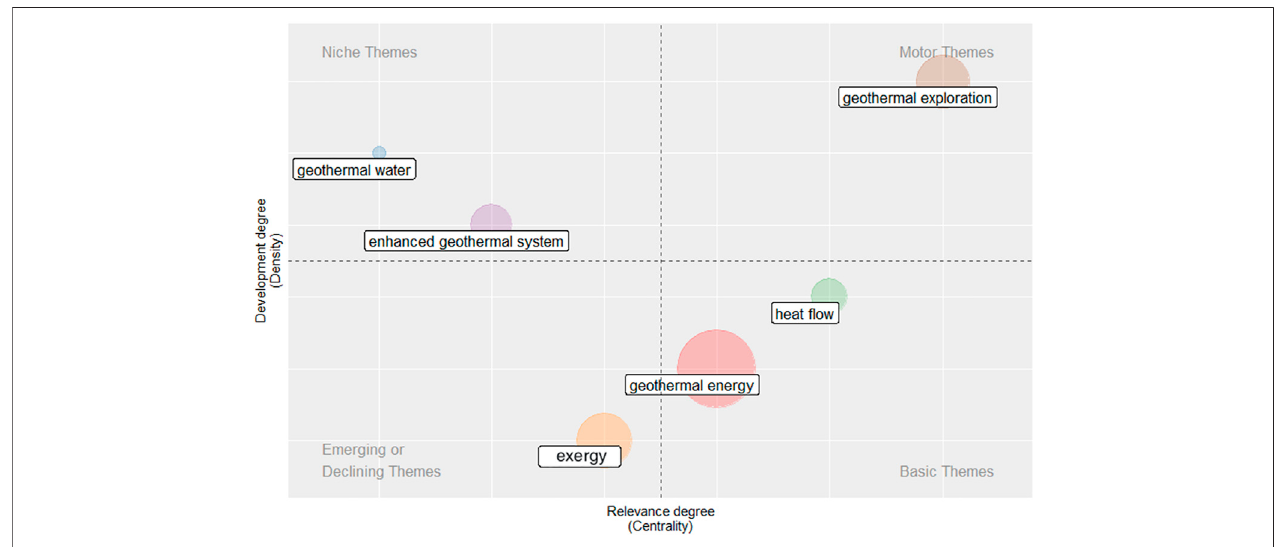
FIGURE 9 | Strategic diagram depicting the research theme of